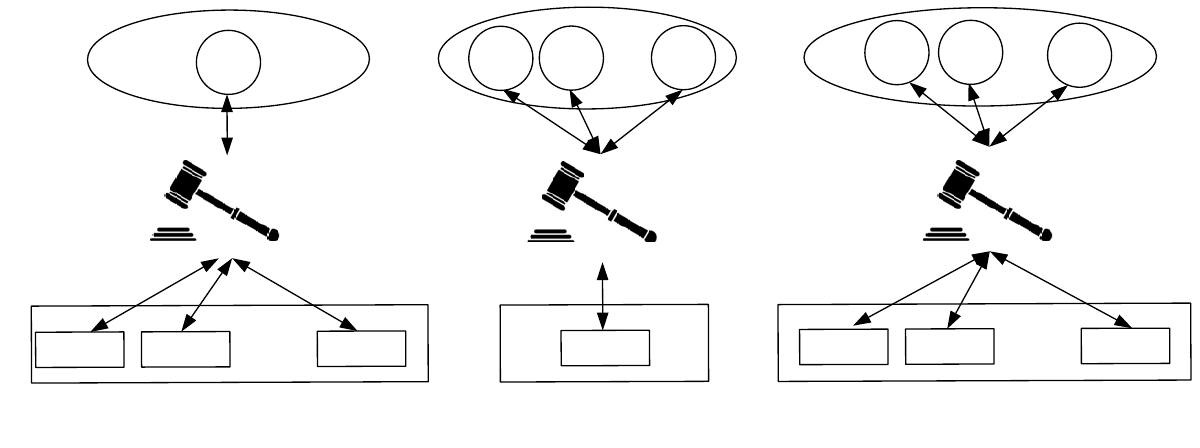
Figure 2. Spectrum trading auctions: (a) forward one-sided spectrum trading auction; (b) reverse one-sided spectrum trading; (c) two-sided spectrum trading